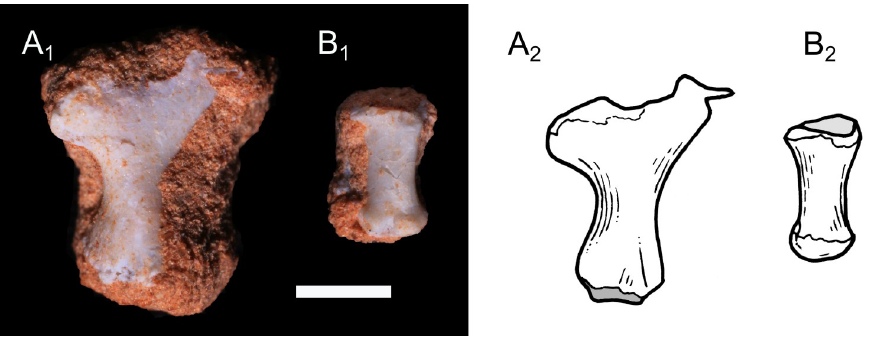
Fig 9. Photography (1) and drawing (2) of the metapod and phalange of Brasilodon quadrangularis (UFRGS-PV- 0765-T). A , fragment of a metapod; B , intermediate phalange, in dorsal view. Scale bar = 2 mm.